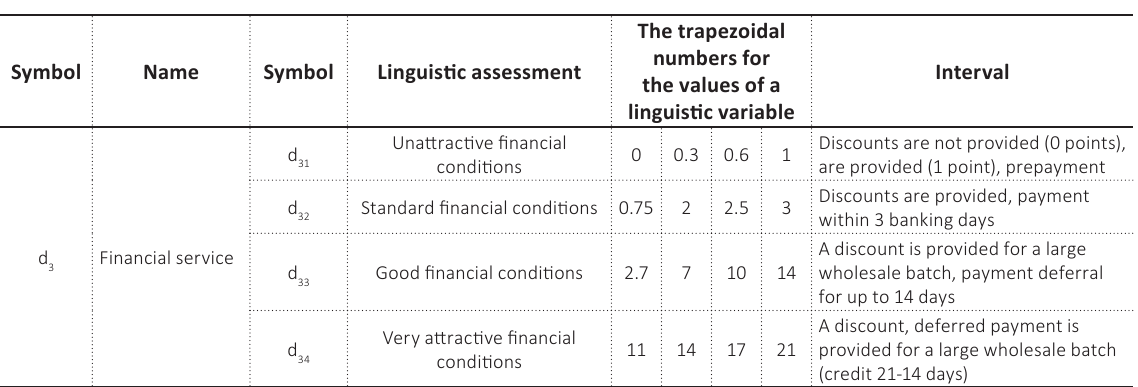
Table A4 (cont.). Indicators for evaluating the level of consumer services (D)